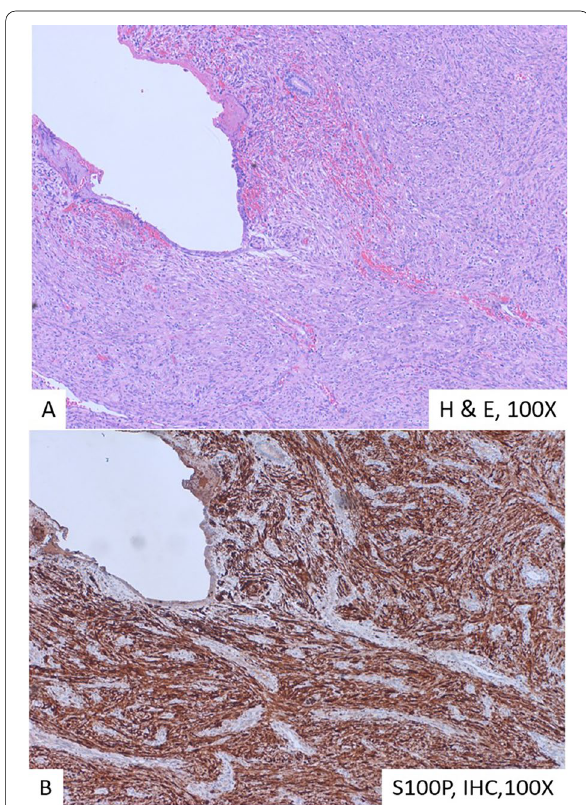
Fig. 3 Photomicrograph showing A cellular spindle cell tumour with minimal nuclear and cellular pleomorphism and intermixed collagen (Hematoxylin and eosin, 200 X); B S 100p is diffusely and strongly positive (IHC X